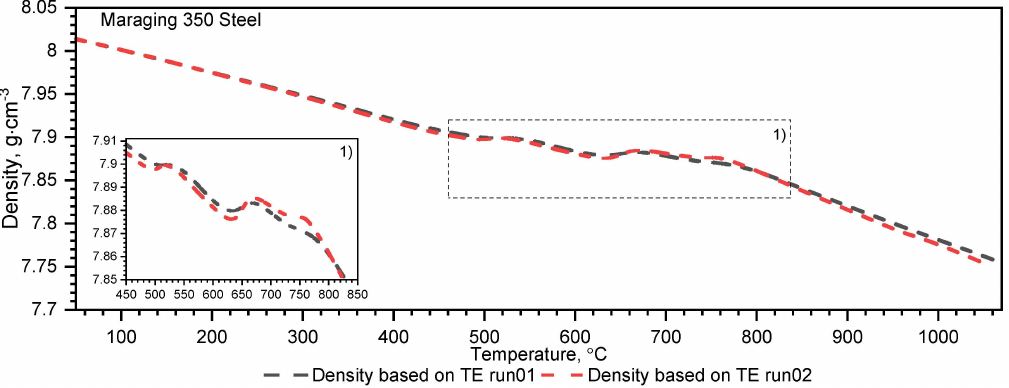
Figure 16. Density as a function of temperature for the Maraging 350 steel obtained from the first and second heating runs on DIL 402 C.